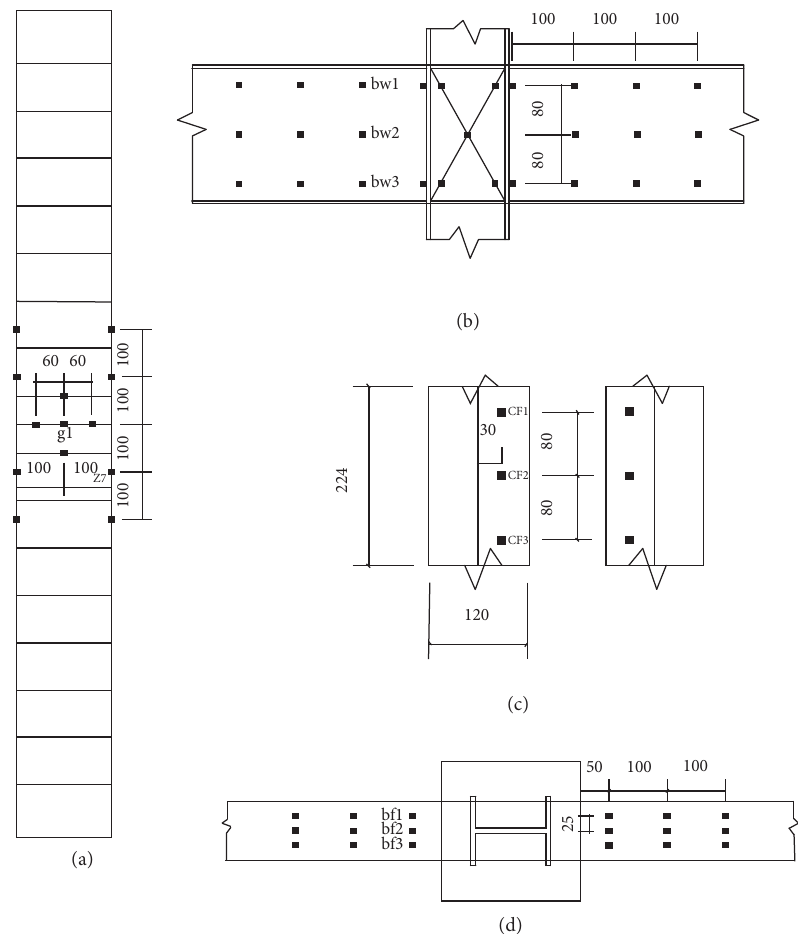
Figure 5: Strain gauges arrangement. (a) Column longitudinal and stirrup reinforcements. (b) Beam web/column web core area. (c) Column flanges. (d) Beam